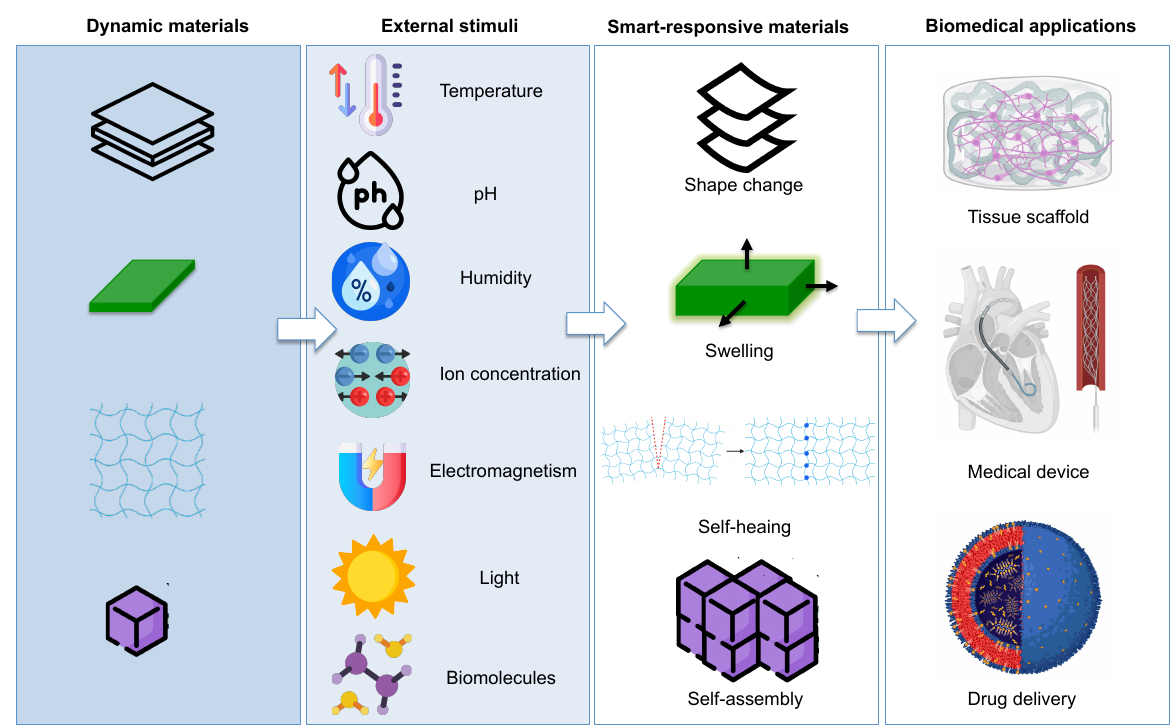
Figure 3. Schematic representation of different types of stimuli, and responses observed in smart materials in terms of shape-shifting, swelling, self-assembly, self-repair, and their possible use in biomedical applications.